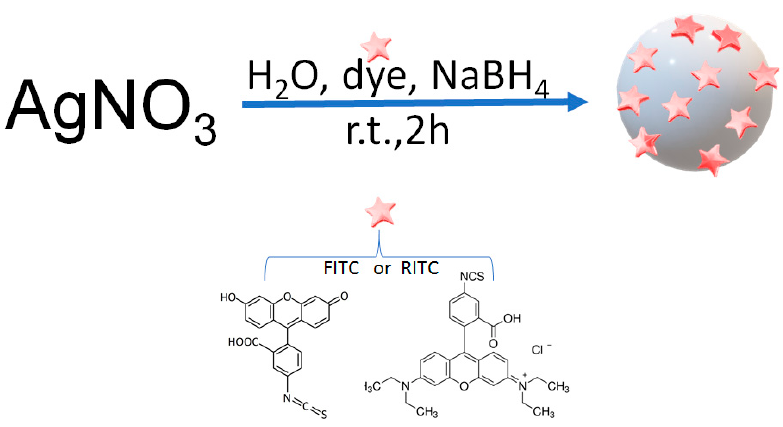
Figure 1. Scheme of silver nanoparticle–fluorescein isothiocyanate (AgNPs–FITC) and silver nanoparticle–rhodamine B isothiocyanate (AgNPs–RITC) synthesis.